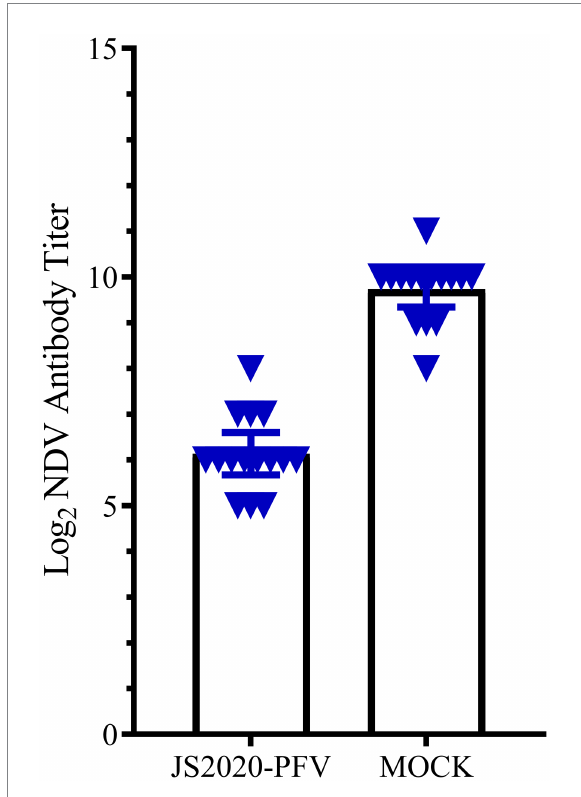
FIGURE 6 The NDV antibody titer in the experience group ( n = 15/ group). All chicks in the experience group were vaccinated with the NDV attenuated live vaccine at 17 d.p.i. The antibody titer against NDV was tested at 22 d.p.i. The NDV antibody titer was 6.3 in the JS2020-PFV group and 10.1 in the mock group ( p <